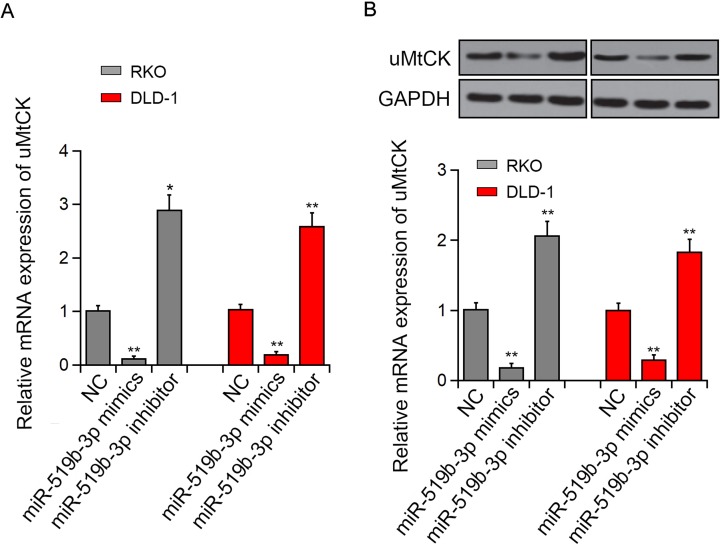
miR-519b-3p repressed the expression of uMtCK. Relative mRNA expression levels of uMtCK in RKO and DLD-1 cells transfected with miR-519b-3p were assessed by qRT-PCR. (B) Relative protein expression levels of uMtCK in RKO and DLD-1 cells were examined by Western blot. *p < 0.05, **p < 0.01 vs. NC. NC, negative control.